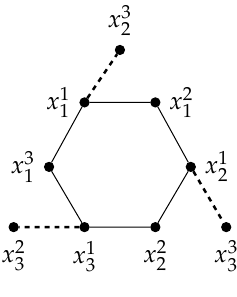
Figure 1. B = ( 3,2,1 )